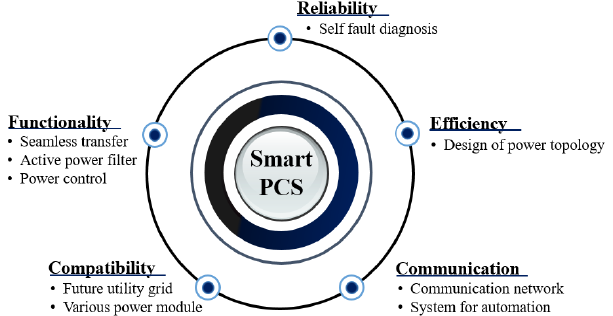
Figure 1. Concept of the smart PCS for